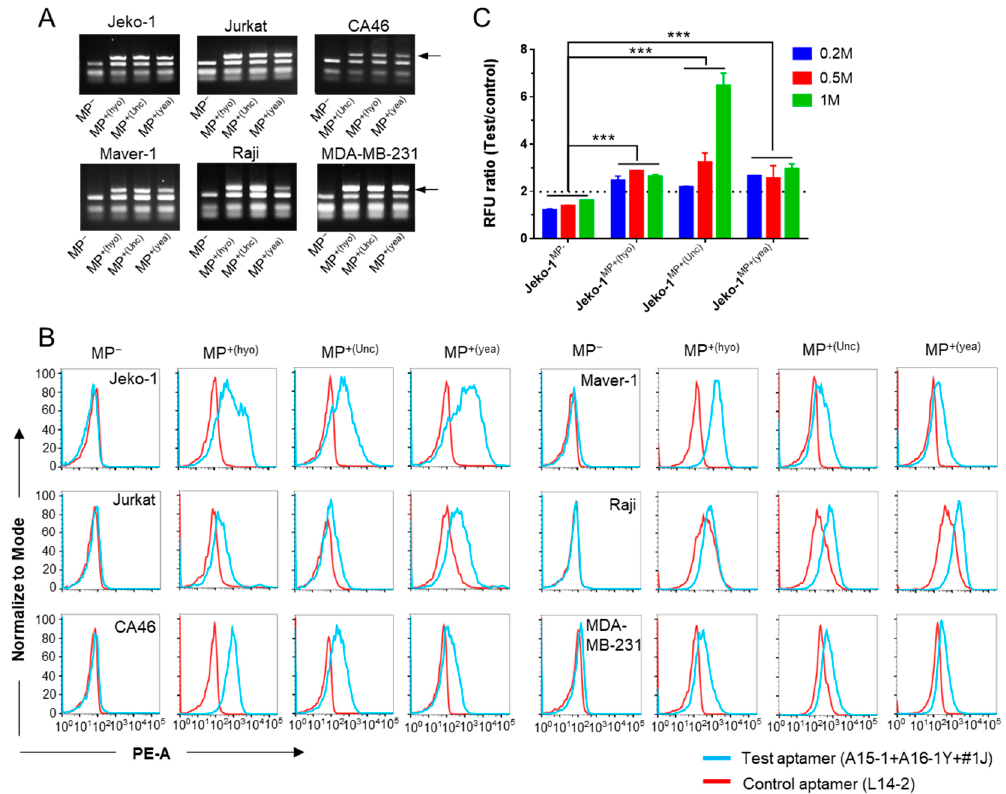
Figure 6. Application of the aptamer cocktail for detection of multiple infection ‐ causing mycoplasma species. ( A ) PCR assays to verify mycoplasma infection status. PCR products were analyzed using 2% agarose gel electrophoresis. Arrows show the PCR amplicons of mycoplasma DNA; ( B ) Histogram plots of flow cytometry results show test (cocktail) or control (L14 ‐ 2) aptamer binding in MP − or MP + cells. Data show representative results from three independent experiments. ( C ) Microplate reader detection of mycoplasma ‐ infected Jeko ‐ 1 cells using the test (cocktail) and control (L7 ‐ 2) aptamers. Different counts (0.2, 0.5, or 1 million) of Jeko ‐ 1 cells were tested. The horizontal dashed line is the cut ‐ off value line that demarcates MP − and MP +(hyo) cells. Data show the mean ± SD of three independent experiments. *** p < 0.001. MP − , mycoplasma negative; MP +(hyo) , M. hyorhinis positive; MP +(Unc) , unclassified mycoplasma negative; MP +(yea) , mixed mycoplasma positive.